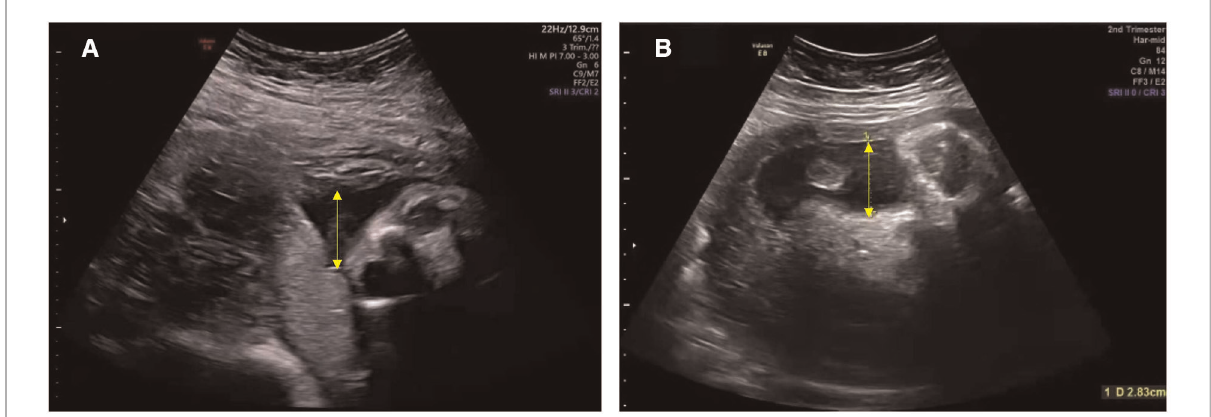
FIGURE 1 Ultrasound showing a reduced volume of amniotic fl uid in the mother during pregnancy. The amniotic fl uid index and the maximum depth (yellow arrow): ( A ) 81 mm and 33 mm at 28 +4 weeks; ( B ) 47 mm and 28 mm at 34 +5 weeks (reference ranges for the index of amniotic fl uid and the maximum depth: >80 mm and >30 mm),